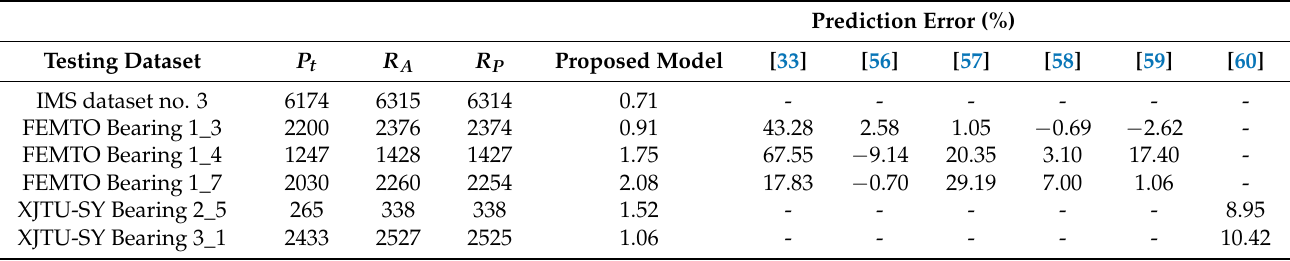
Table 4. RUL results in comparison with other works.